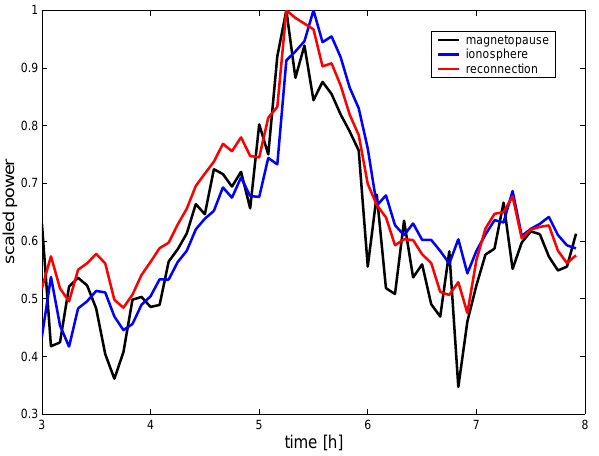
Fig. 10. The reconnection power (red), the energy input through the magnetopause (black) and the power deposited in the ionosphere (Joule heating + particle precipitation, blue), in the 15 August 2001 substorm run. Curves are scaled for comparison and their real max- imum values are: magnetopause 1 . 7TW, reconnection 0 . 74TW, ionosphere 20GW.